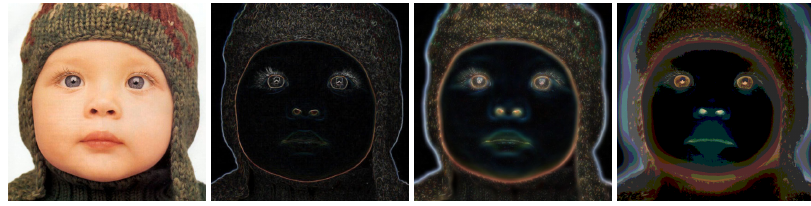
Figure 9. The result of the frequency-away weight feature when E = 1,10, and